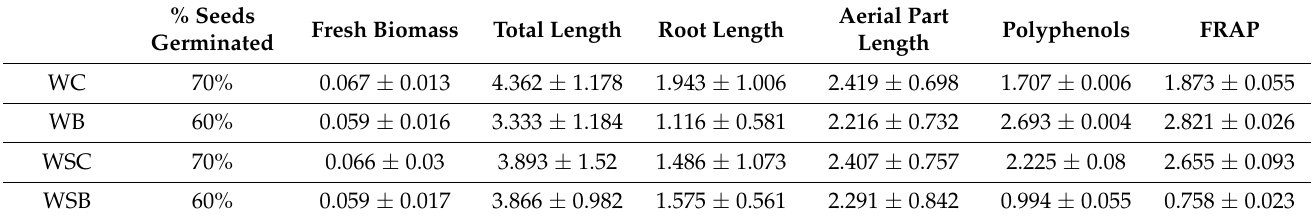
Table 3. Parameters measured for the germination tests in the presence of four different treatments: % of germinated seeds; fresh biomass of the sprouts expressed as grams; the lengths of the sprouts, root apparatus, aerial part expressed in cm; polyphenols expressed as mg GAE/g FW; FRAP expressed as mg Fe 2+ /g FW. Values are the average ± standard deviation obtained as described in the Materials and Methods